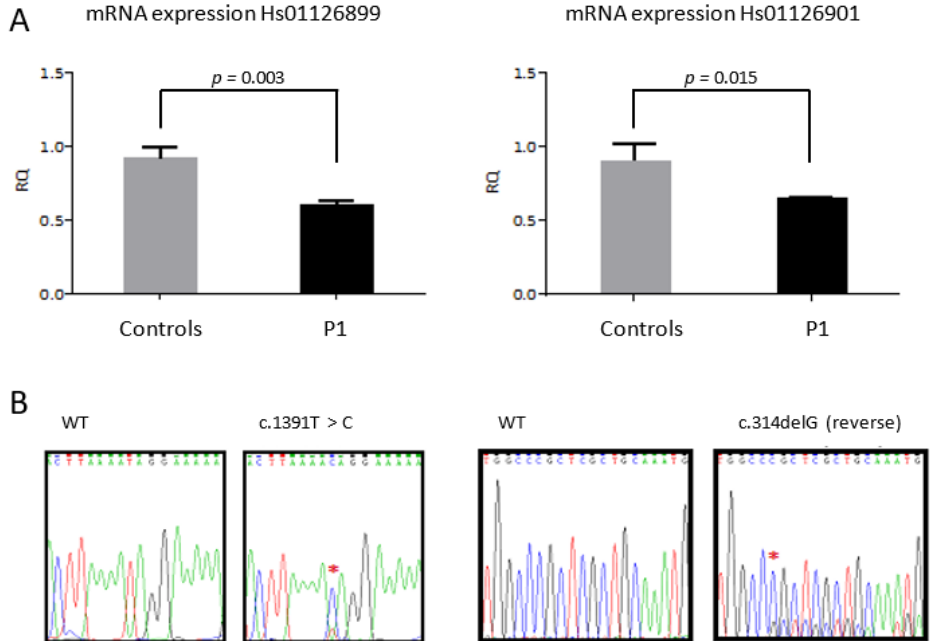
Figure 2. Expression levels of YARS2 transcript in fibroblasts from patient P1. ( A ) YARS2 mRNA content of fibroblasts from P1 and 5 controls (C1-C5) using Taqman assays (located in exon 1-2 boundary (Hs01126899) and in exon 3-4 boundary (Hs01126901)). ( B ) Electropherogram of P1 cDNA sample and WT sample of c.314delG and c.1391T > C sequences.